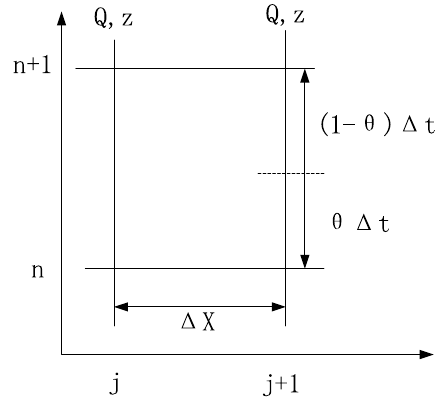
Fig. 3 Preissmann format grid